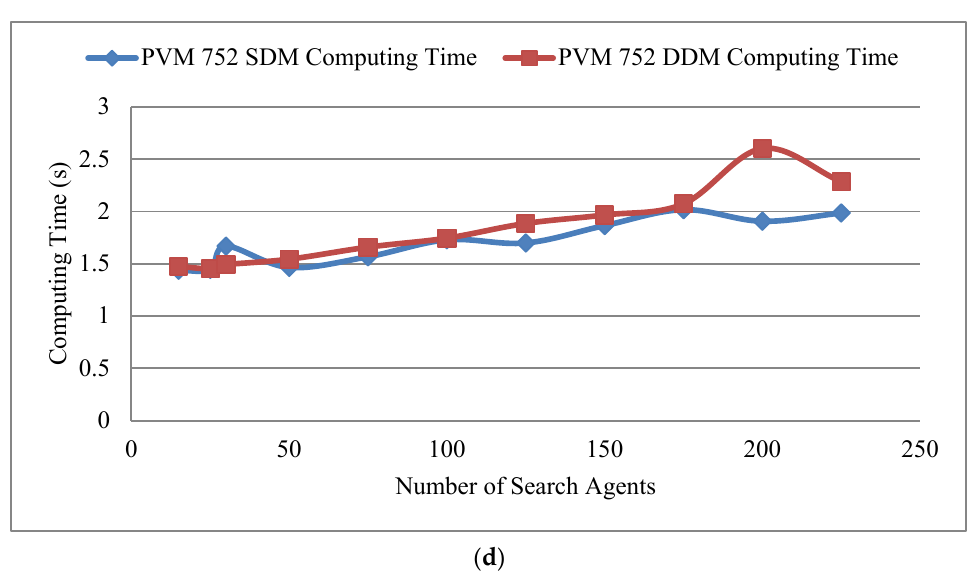
Figure 15. BWOA computing time vs. the number of search agents ( a ) RTC cell, ( b ) aSi Cell, ( c ) PWP 201 panels, and ( d ) PVM 752 panel.